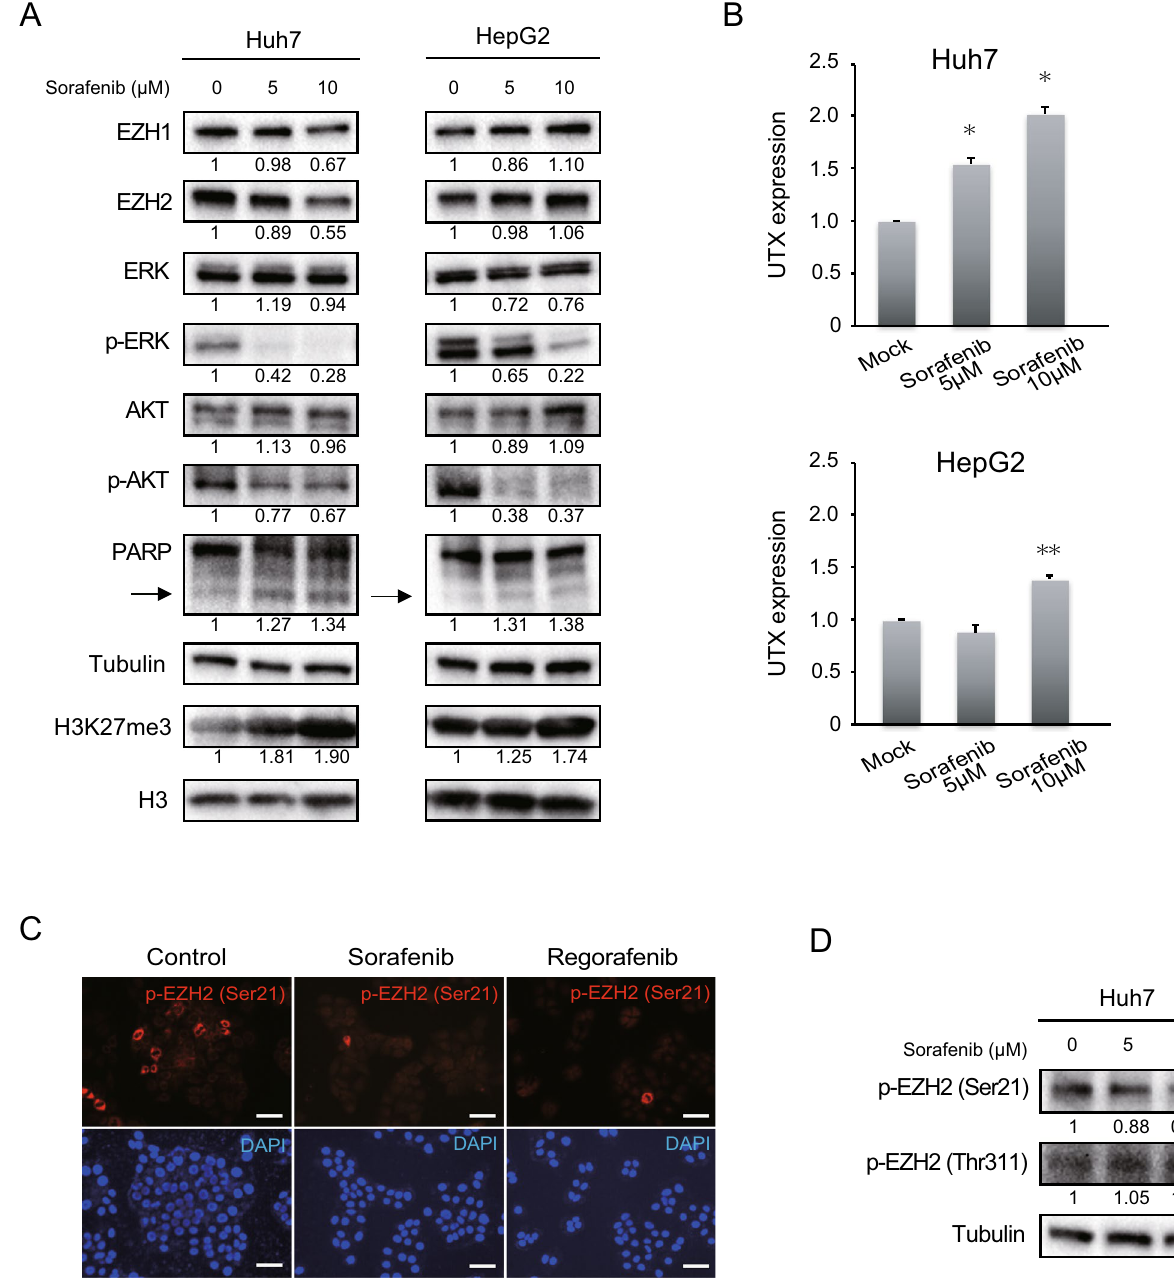
Figure 4. An increase in H3K27me3 levels caused by sorafenib in liver cancer cells. ( A ) Cells treated with sorafenib in varying concentration for 48 h were subject to Western blot analyses. The arrow indicates the cleaved form pf PARP. RI was shown as the means of three independent experiments. ( B ) Real-time PCR analyses of the UTX expression in cells treated with sorafenib for 48 h (Student’s t test, * p < 0.01, ** p < 0.05) ( C ) Immunocytochemical analyses for phospho-EZH2 at serine 21 (Ser21) (red) and DAPI (blue) after treatment of Huh7 cells with sorafenib (5 μM) and regorafenib (5 μM) for 48 h. Scale bar = 50 µm. ( D ) Cells treated with sorafenib and GSK126 or UNC1999 were subjected to Western blot